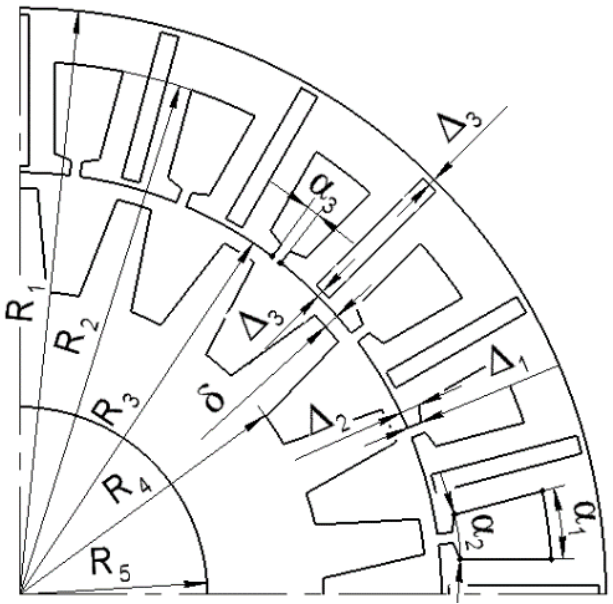
Figure 3. PMFSG parameters. Figure 3. PMFSG Table 3. Fixed parameters of the PMFSG. t s : the angular tooth pitch of the stator.